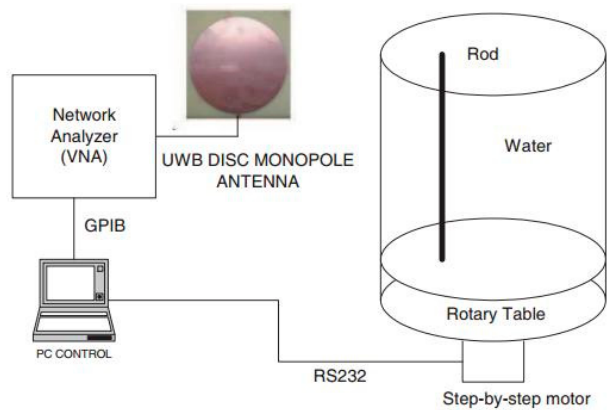
Figure 9. Experimental setup of working prototype [63].